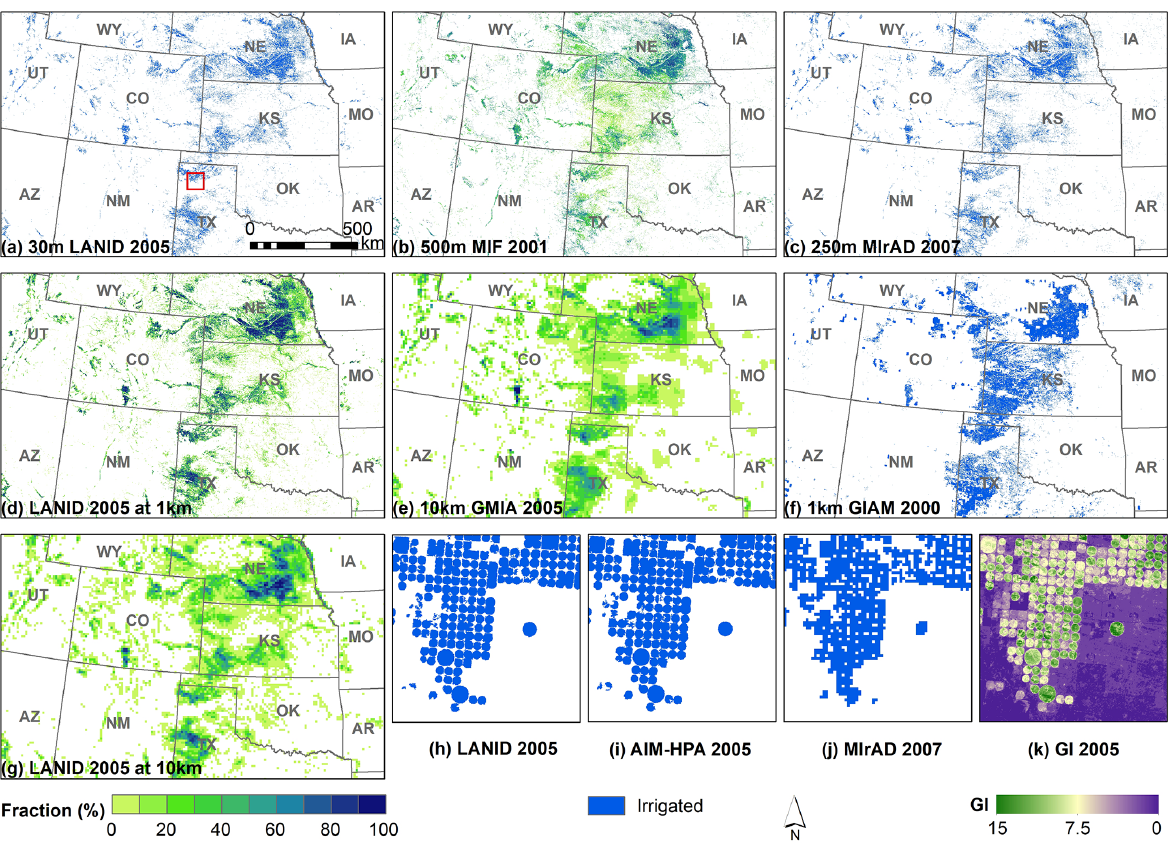
Figure 12. Product comparison at the High Plains aquifer. In addition to the original 30m LANID (a) , the map is aggregated to 1 and 10km resolution for panels (d) and (g) . Panels (h–i) show the location highlighted in (a) (red